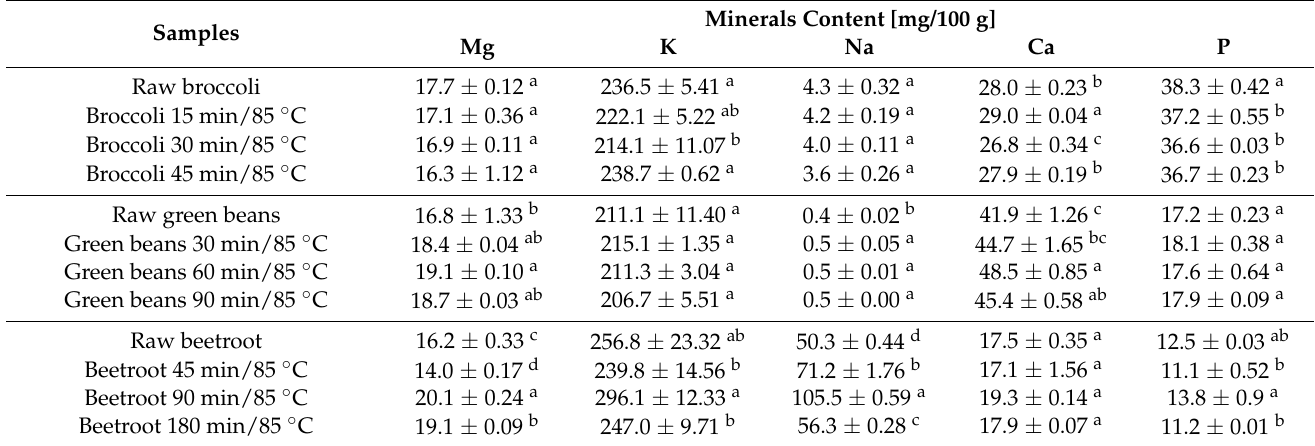
Table 3. The content of selected minerals in the tested samples of raw and conducted to sous-vide treatment